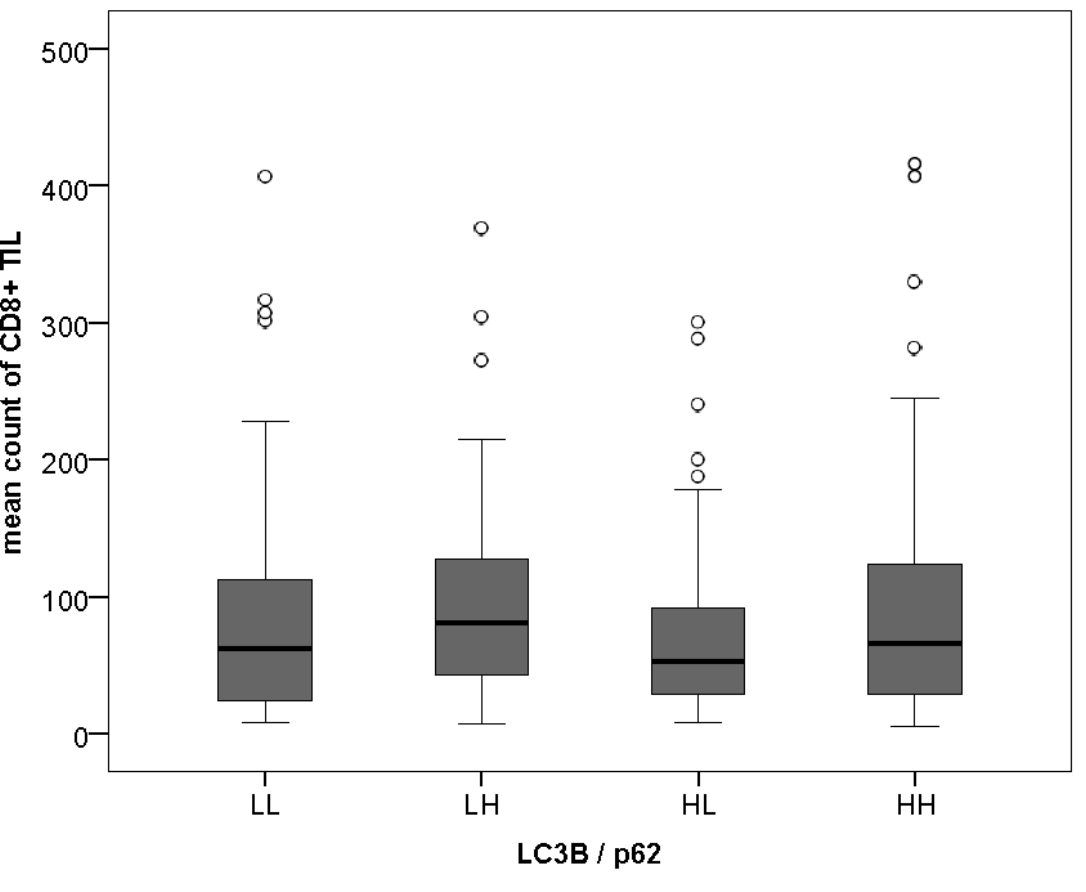
Figure 2. LC3B/p62 patterns and CD8+Tumor-infiltrating Lymphocytes. LL = LC3B low p62 low ; LH = LC3B low p62 high ; HL = LC3B high p62 low ; HH = LC3B high p62 high , ° indicate outliers.